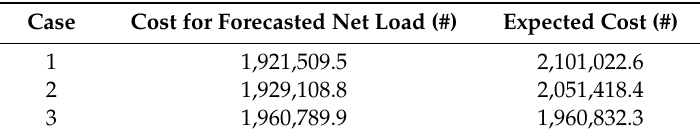
Table 3. Comparison of numerical